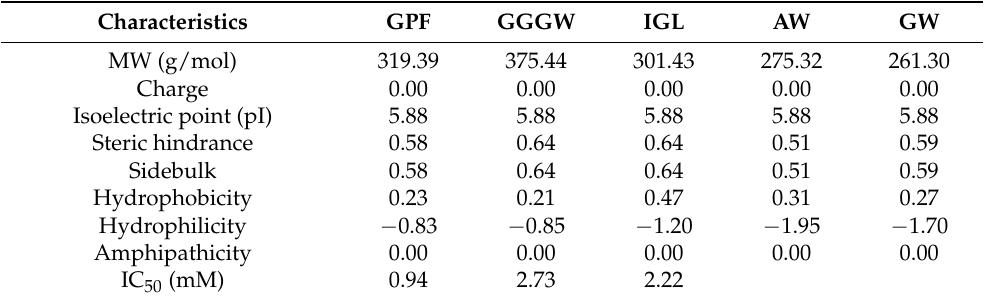
Table 2. Main physicochemical characteristics attributed to the peptides in this study.